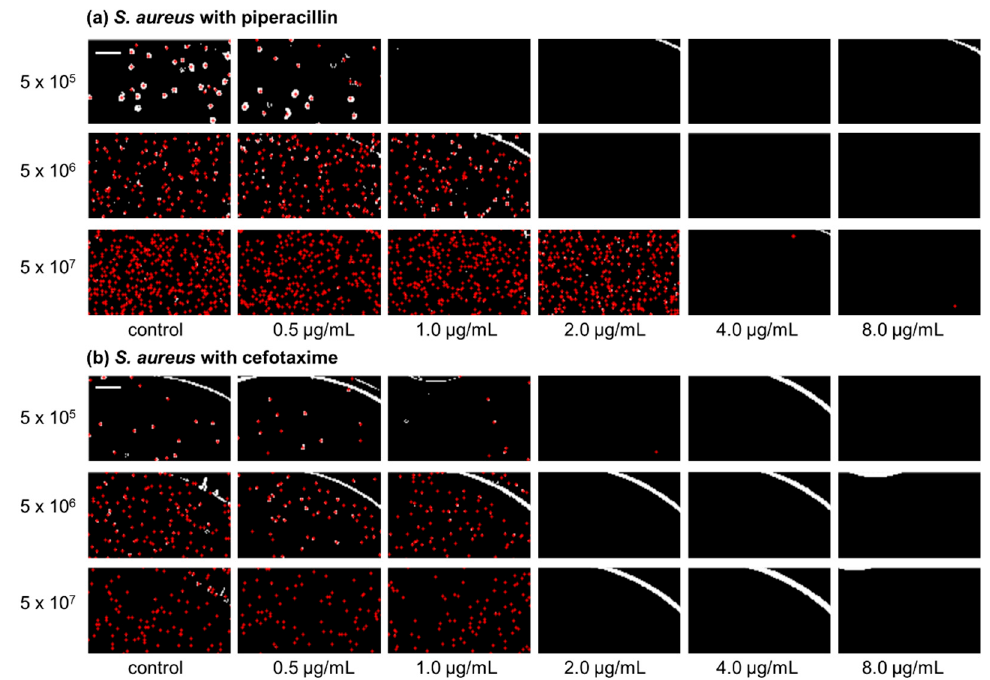
Figure 1. Processed images of S. aureus with three different concentrations, 5 × 10 5 , 5 × 10 6 , and 5 × 10 7 CFU/mL, after 6 h of incubation exposed to piperacillin and cefotaxime. Red dots in the images illustrate the colonies of bacteria that were recognized by image processing. ( a ) Representative images of S. aureus with piperacillin. ( b ) Representative images of S. aureus with cefotaxime. The scale bar represents 200 μ m. Table 1. Minimal inhibitory concentration (MIC) values of S. aureus according to different bacterial inoculum sizes and volumes of culture media with antibiotics. The unit of MIC is µ